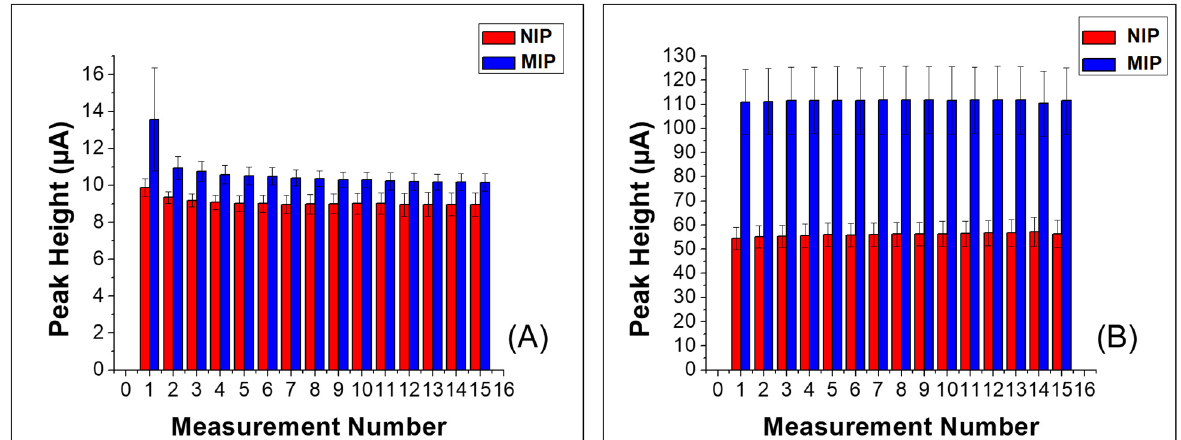
Figure 4. Repeatability measurements of MIP and NIP for ( A ) DNP and ( B ) TNT ( n = 3).